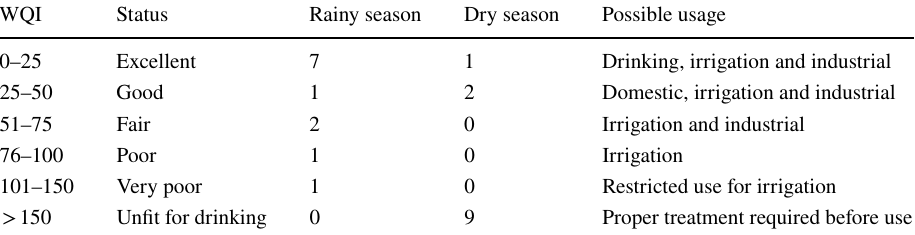
corresponding water quality status